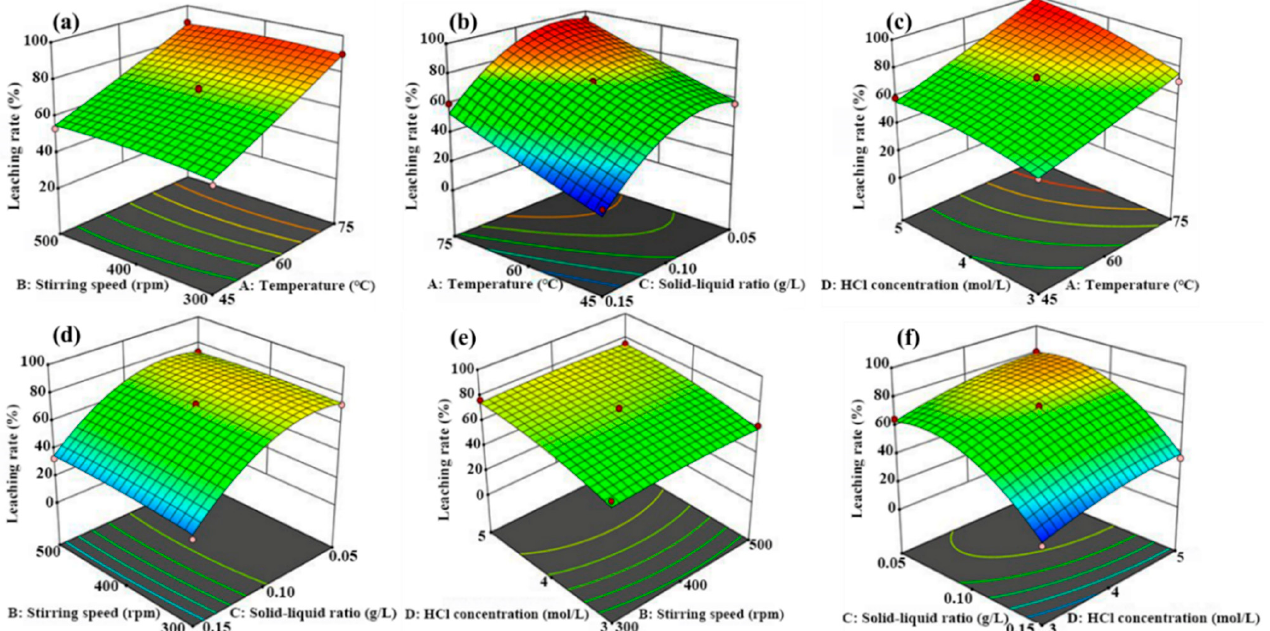
Figure 4. Relationships between both experimental parameters and Sn leaching rates ( a ) temperature and stirring speed, ( b ) temperature and solid–liquid ratio, ( c ) temperature and HCl concentration, ( d ) solid–liquid ratio and stirring speed, ( e ) stirring speed and HCl concentration and ( f ) solid–liquid ratio and HCl concentration.